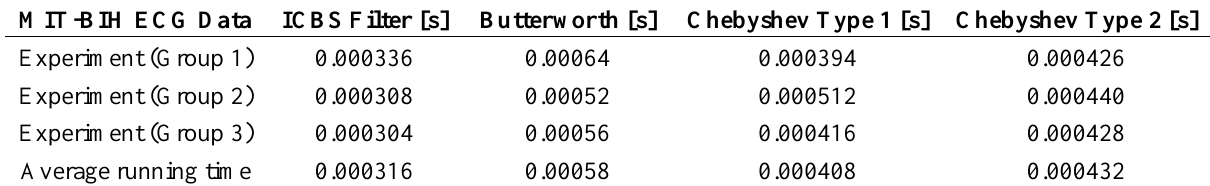
Table 1. ECG Filter running